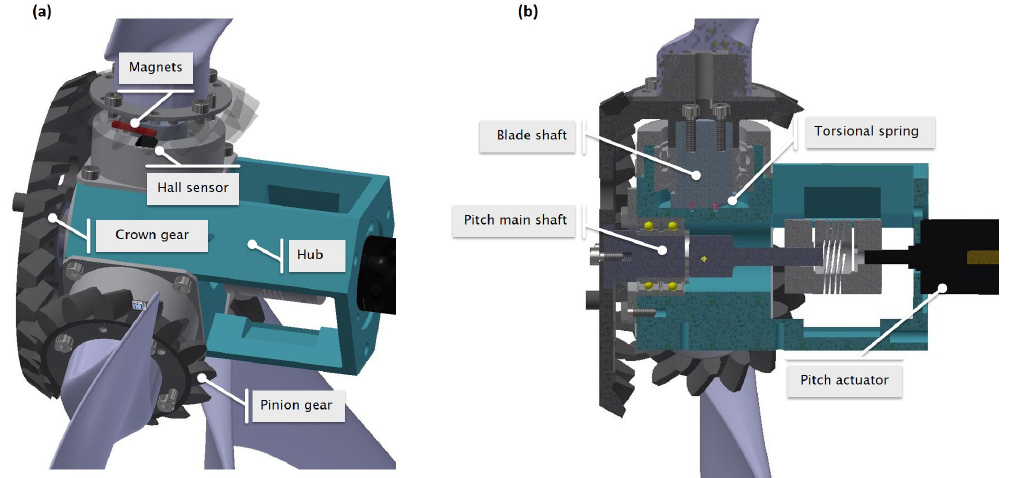
Figure 3. Different views of the hub assembly. View with one transparent blade gear, to show the magnets and Hall sensor (a) . View where the assembly has been cut to reveal hidden elements (b)